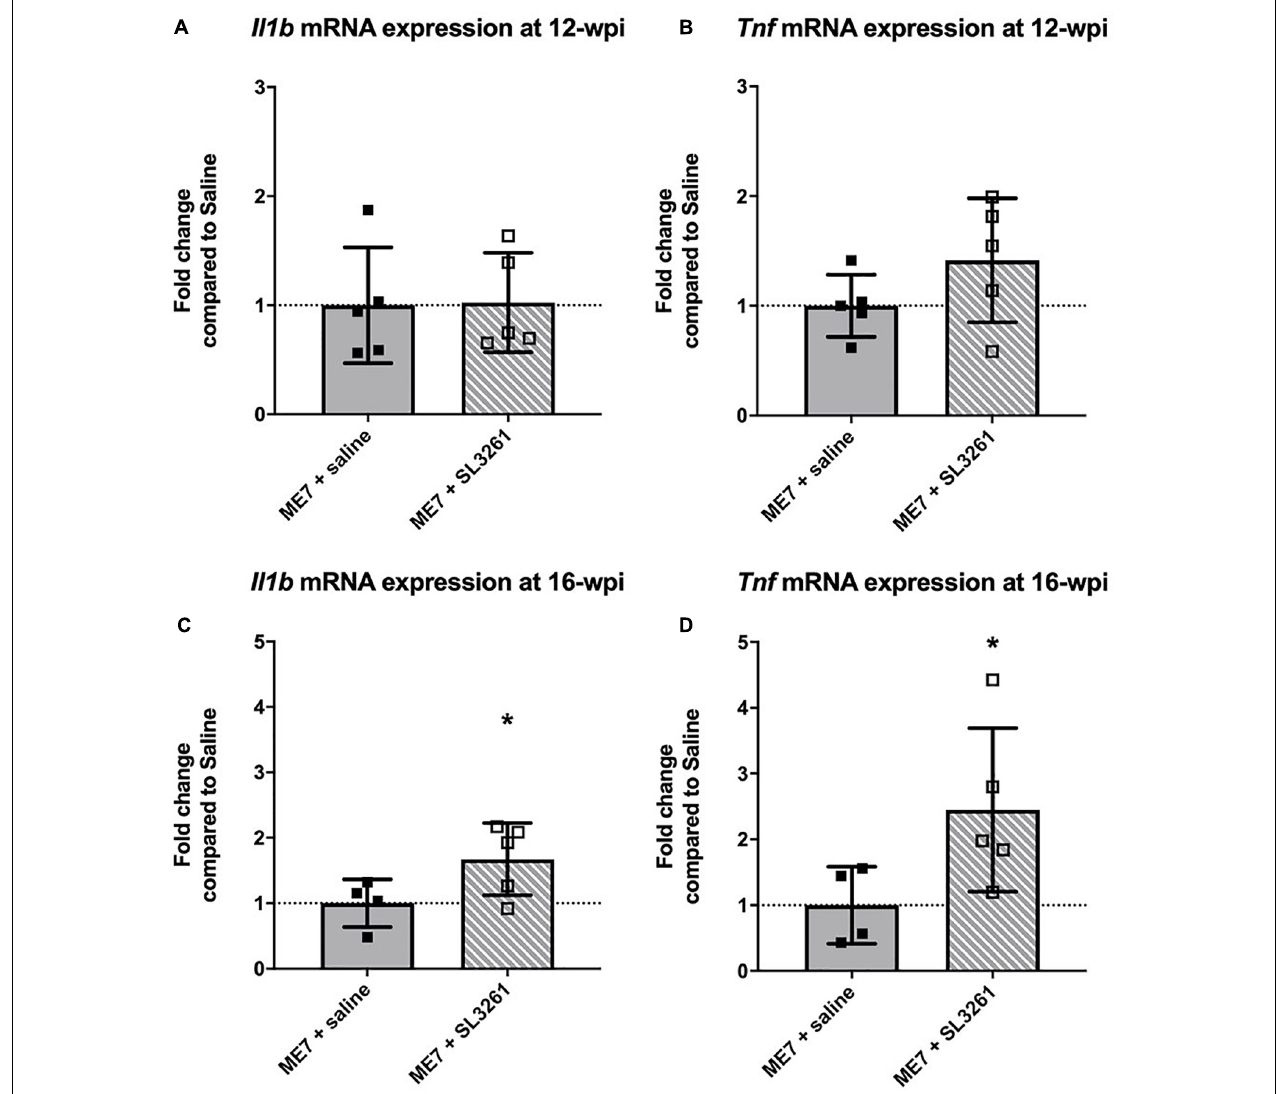
FIGURE 3 | Cytokine gene transcription. The impact of systemic bacterial infection on central cytokine gene transcription in ME7 prion mice at 12-wpi (A,B) and at 16-wpi (C,D) , 4 weeks after injection of saline or S. typhimurium SL3261 (10 6 cfu, i.p.). mRNA expression of inflammatory cytokines IL-1 β (A,C) and TNF- α (B,D) was increased following infection in ME7 prion mice at 16-wpi, but not 12-wpi. * p < 0.05 using one-tailed unpaired Students’ t -test; n = 4–5/group.